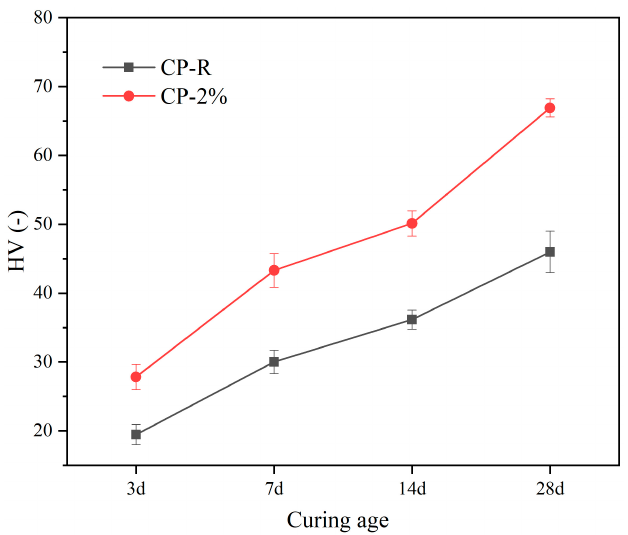
Figure 3. The microhardness curves of the paste samples with and without TiO 2 @CoAl-LDH core@shell nanospheres at various curing ages. core@shell nanospheres at various curing